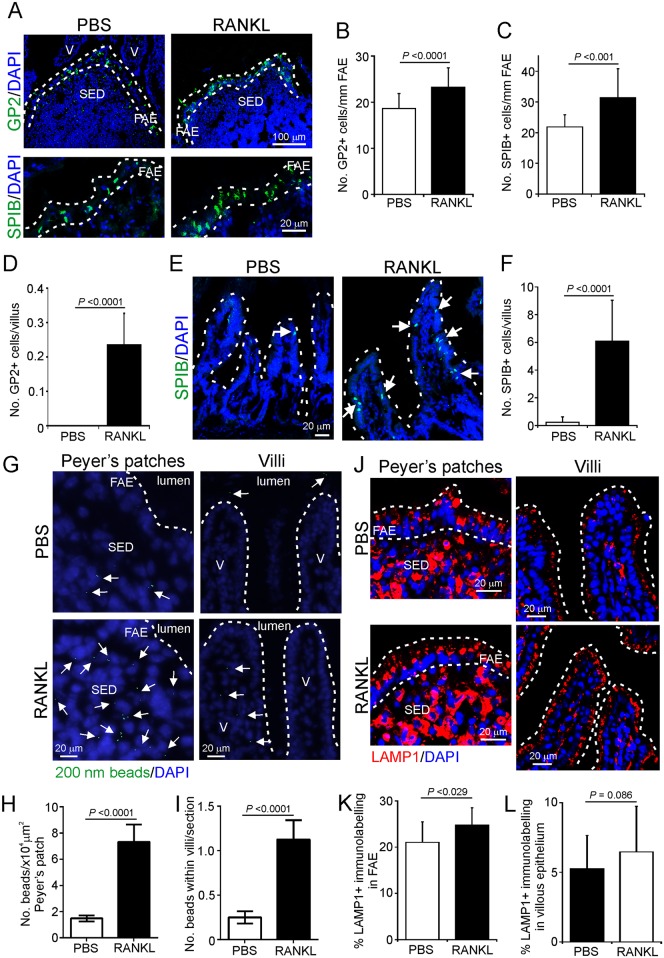
RANKL treatment enhances the density of M cells in the follicle associated epithelium (FAE) of the Peyer’s patches and the villous epithelium of the intestine.The density of functionally mature M cells in the intestine can be promoted in mice through exogenous administration of RANKL. Here, C57BL/6 mice were treated daily with RANKL (or PBS as a control) to induce M cell-differentiation. Peyer’s patches and intestines were collected on d 3 of treatment, coincident with the peak period of induction of M-cell gene expression in the gut epithelium [22, 35]. A-F) Sections of Peyer’s patches and villous epithelium were stained for the M cell markers GP2 and SPIB. A) Representative distribution of GP2+ (green, mature M cells, upper-panels) and SPIB+ (green, within the nuclei of differentiating and mature M cells, lower panels) M cells in the Peyer’s patches of mice from each group. Broken lines indicate the boundary of the FAE. SED, subepithelial dome; V, villi. Morphometric analysis confirmed a significant increase in the number of (B) GP2+ and (C) SPIB+ M cells in the Peyer’s patches of RANKL-treated mice (GP2, P<0.0001; SPIB, P<0.001, Student’s t-test; 4–5 FAE/mouse, n = 4 mice/group). D) Morphometric analysis also revealed a significant increase in the number of GP2+ M cells in the villous epithelium after RANKL-treatment (P<0.0001, Mann-Whitney U test; 5–7 sections/mouse, n = 4 mice/group). E) Representative distribution of SPIB+ cells (green, arrows) in the villous epithelium of RANKL- and PBS-treated mice. Broken lines indicate the lumenal surface of the gut epithelium. F) Morphometric analysis confirmed a significant increase in the number of SPIB+ cells in the villous epithelium after RANKL-treatment (P<0.0001, Mann-Whitney U test; 3–16 sections/mouse, n = 4 mice/group). G) C57BL/6 mice were treated daily with RANKL (or PBS as a control) to induce M cell-differentiation and on d 2 orally-gavaged with 2x1011 fluorescent microbeads. Peyer’s patches and intestines were collected 24 h later to compare the functional ability of M cells in the intestines of mice from each group to acquire and transcytose particulate antigens. Fluorescent microbeads (green, arrows) were detected in sections of Peyer’s patches (left-hand panels) and intestine (right panels) by fluorescence microscopy. V, villi; broken line, lumenal surface of the gut epithelium. In the intestines of RANKL-treated mice the number of fluorescent microbeads in (H) the SED of the Peyer’s patches (P<0.0001, Mann-Whitney U test; 27 Peyer’s patch sections/mouse, n = 4 mice/group) and (I) villi (P<0.0001, Mann-Whitney U test; 24 intestine sections/mouse, n = 4 mice/group) was significantly increased. J) Sections of Peyer’s patches and villi from PBS- and RANKL-treated mice were also immunostained to identify LAMP1+ endosomes (red) in the epithelium. Broken lines indicate the boundary of the epithelium. K&L) Morphometric analysis of the % area of LAMP1+ immunostaining in (K) the FAE (1–6 FAE per mouse, n = 4 mice/group) and (L) villous epithelium (3–14 villi sections per mouse, n = 4 mice/group. DAPI (blue) was used to counterstain nuclei throughout.